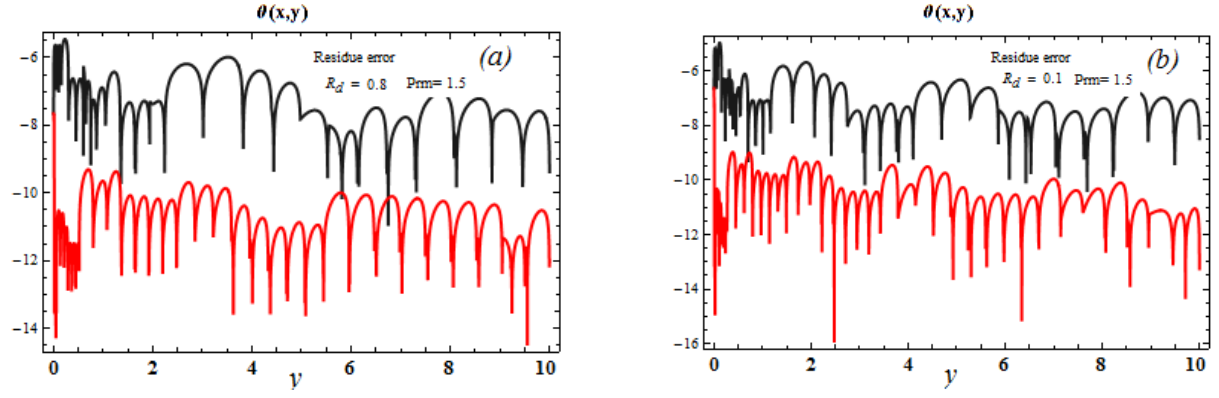
Figure 6. Residue error for temperature for physical parameters ( a ) = 0.8 and ( b ) = 0.1 .